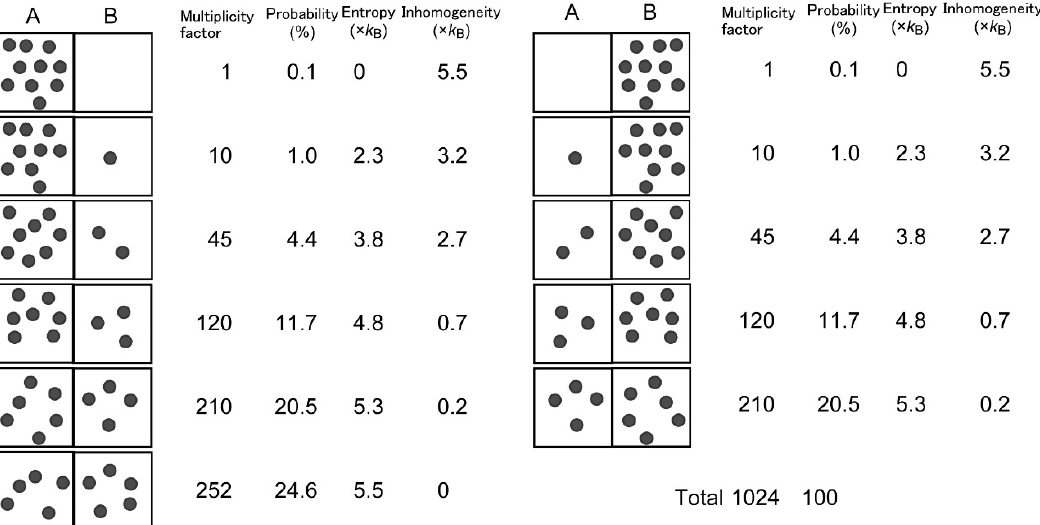
Figure 1. Uneven distribution is evaluated by inhomogeneity and probability.